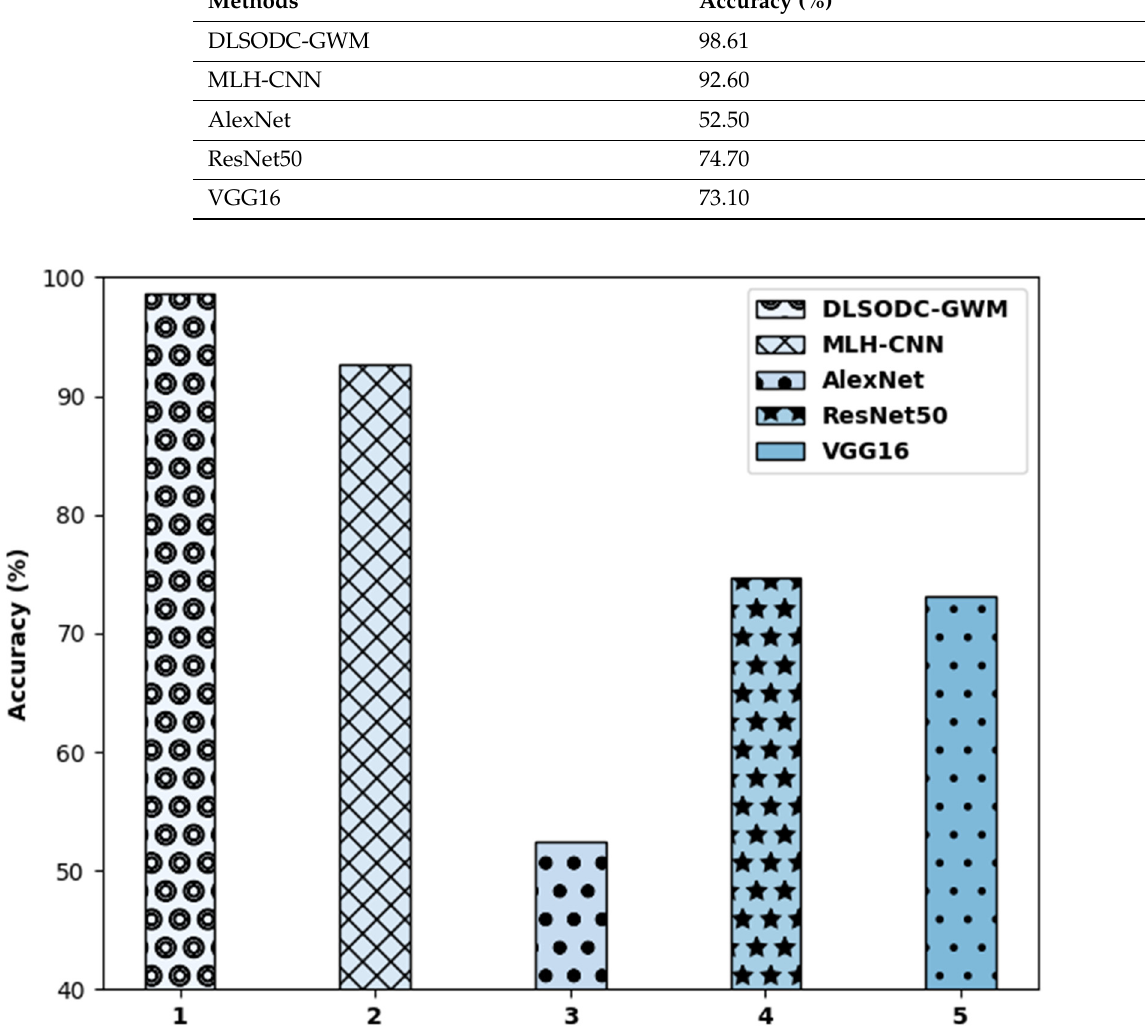
Table 4. Comparative analysis of DLSODC ‐ GWM technique with recent approaches.